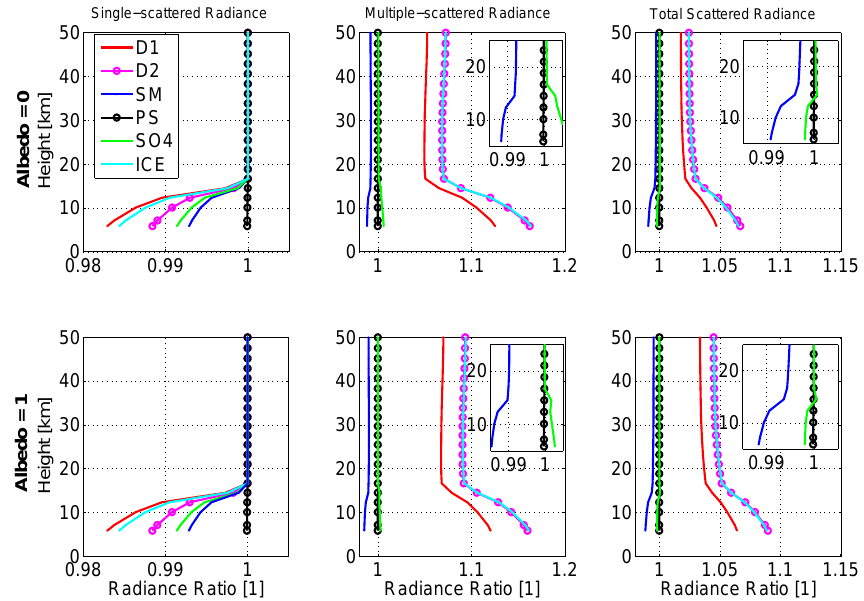
Fig. 7. Simulations of radiance due to air plus a given aerosol species divided by radiance due to air only at 337nm. Species details are in Table 2. The left column shows single-scattered radiance, the middle column shows multiple-scattered radiance, and the right column shows total scattered radiance, as viewed by OSIRIS for SZA ∼ 65 ◦ and for SAA ∼ 70 ◦ . The top row shows simulations for an albedo of 0 while the bottom row shows simulations for an albedo of